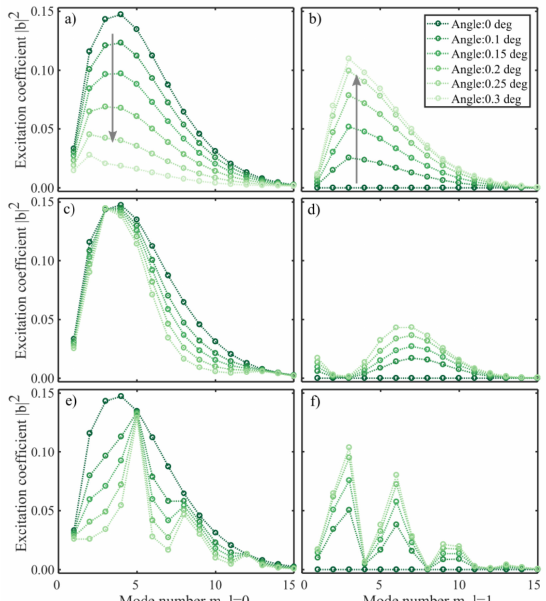
Figure 5. Excitation coe ffi cients (Equation (6)) at the 1550 nm re-imaging length (29.8 mm) ( a , b ), at 1550 nm (14.2 mm), and at 1216 nm (14.2 mm), as a function of the cleave angle. The excitation of radial modes ( l = 0 ) decrease ( a ) as the power of the azimuthal modes ( l = 1 ) increase ( b , d , f